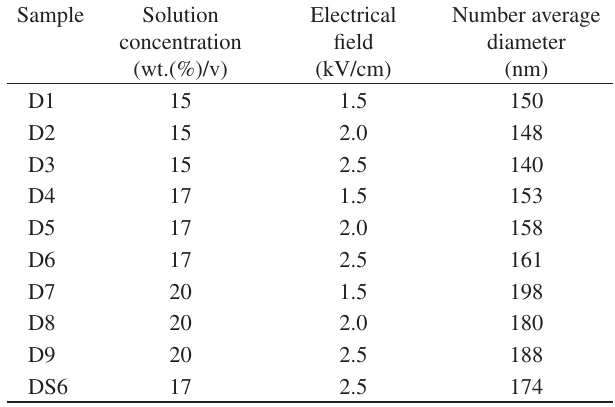
Table 3. Electrospinning conditions of sample D.